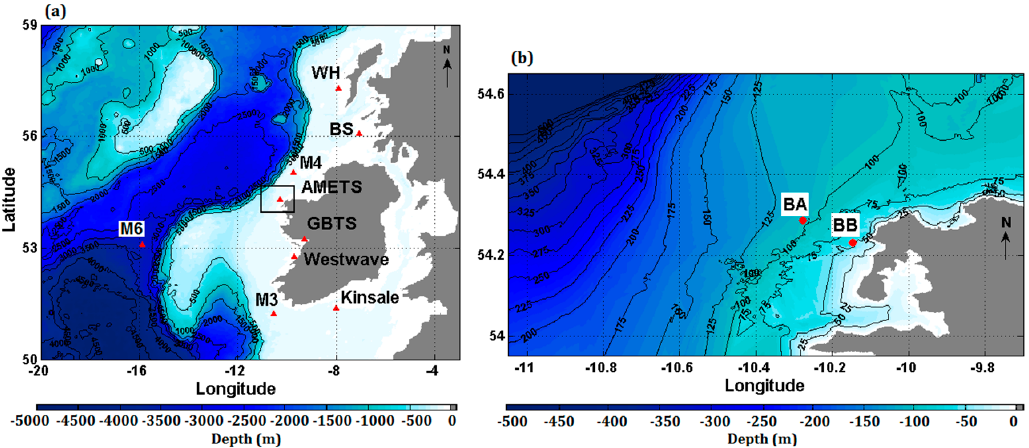
Figure 1. Extents of domains and wave buoy locations for ( a ) coarse Ireland (CI) and ( b ) Atlantic Marine Energy Test Site (AMETS) wave models. WH: West Hebrides; BS: Black Stone; and GBTS: Galway Bay test site.